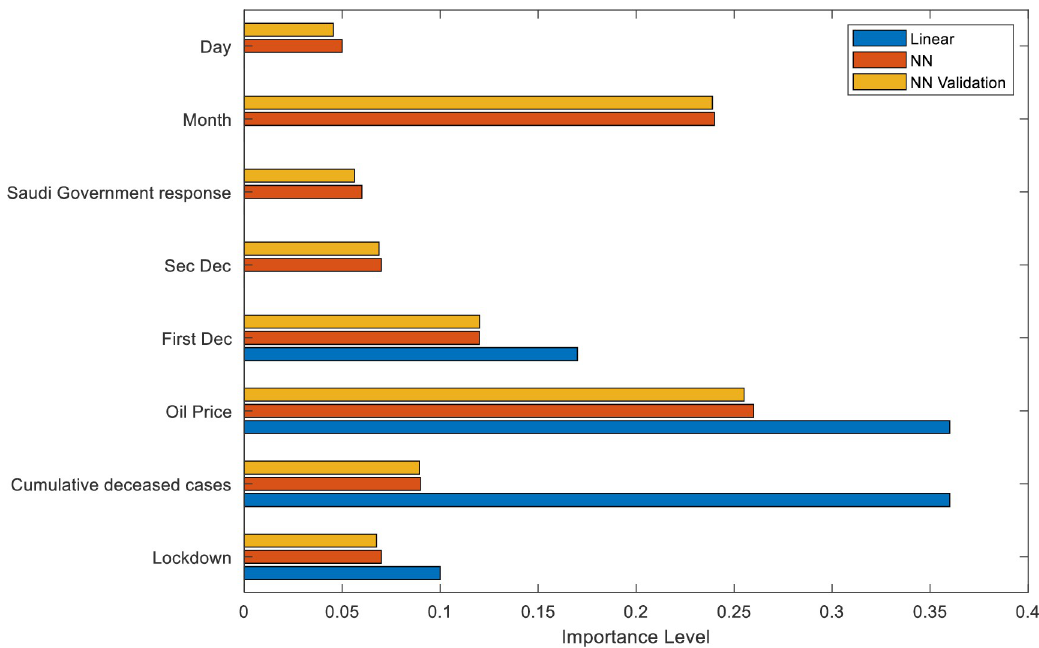
Fig 6. Predictor importance for predicting stock market using neural network and linear